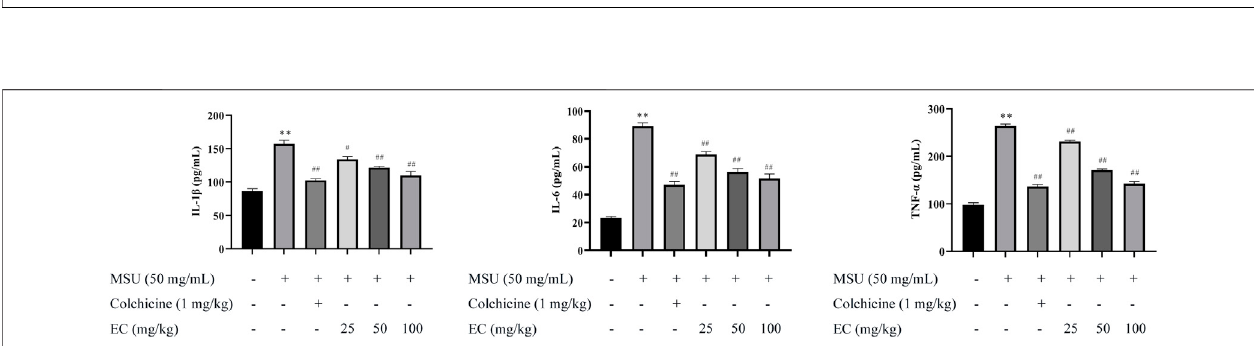
FIGURE 5 | Effect of EC on the histological changes of the ankle joint 24 h after MSU injection. Mice were intragastrically administrated with different doses of EC consecutivelyfor7 days, followedbyMSU (0.025 mlMSUsuspensionwith50 mg/ml)injection intotheankle1 h afterEC administration onthe sixthday.Theanklejoint 24 h after MSU injection was fi xed in the 4% paraformaldehyde solution and stained with hematoxylin and eosin (HE). A representative HE staining image of the mice ankle joint in each group is shown (× 400, scale bar: 100 μ m). The arrows represent leukocyte in fi ltration.